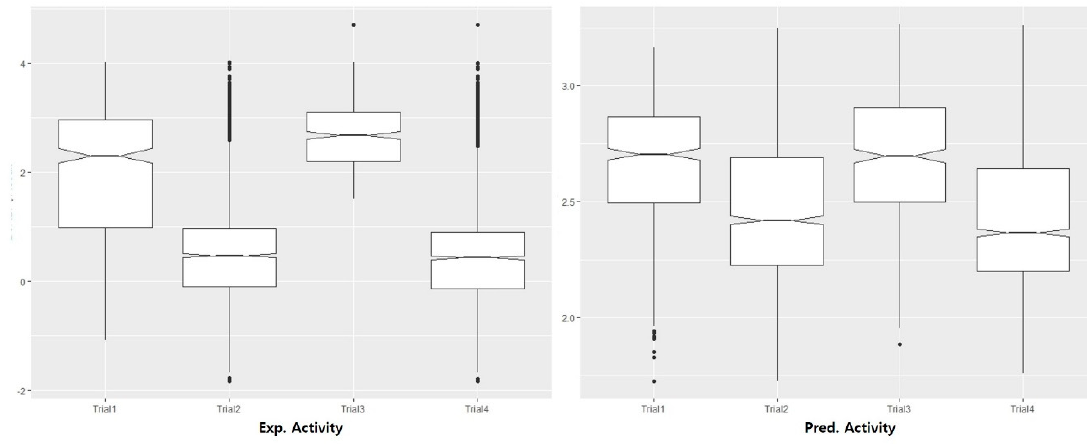
Figure 8. APRRR 215 skeletal box-and-whisker plot.